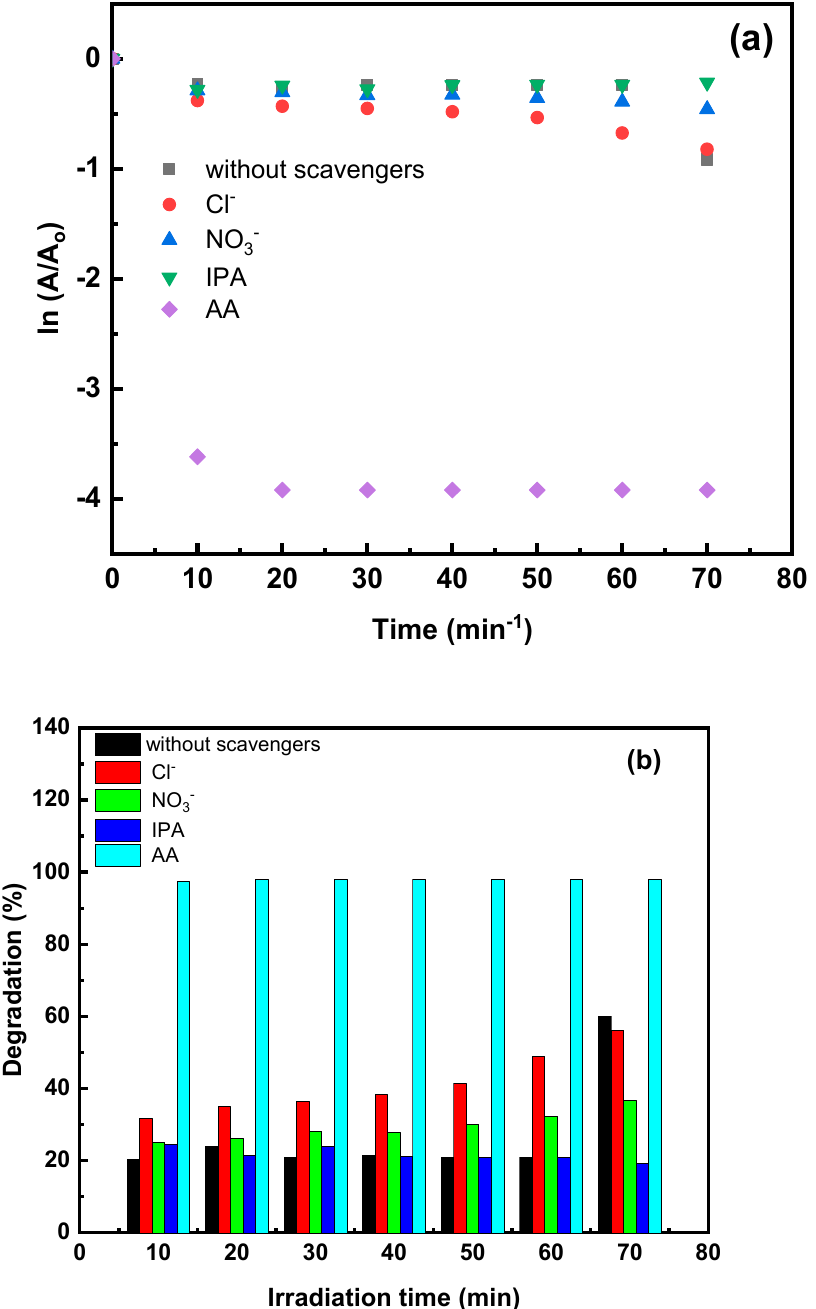
Figure 11. Trapping experiments of active species for the MB photocatalytic reaction using 7.5% Nd 2 O 3 doped CuO under visible light irradiation using 200 mM scavengers, ( a ) kinetics, ( b ) Degra- dation efficiency.